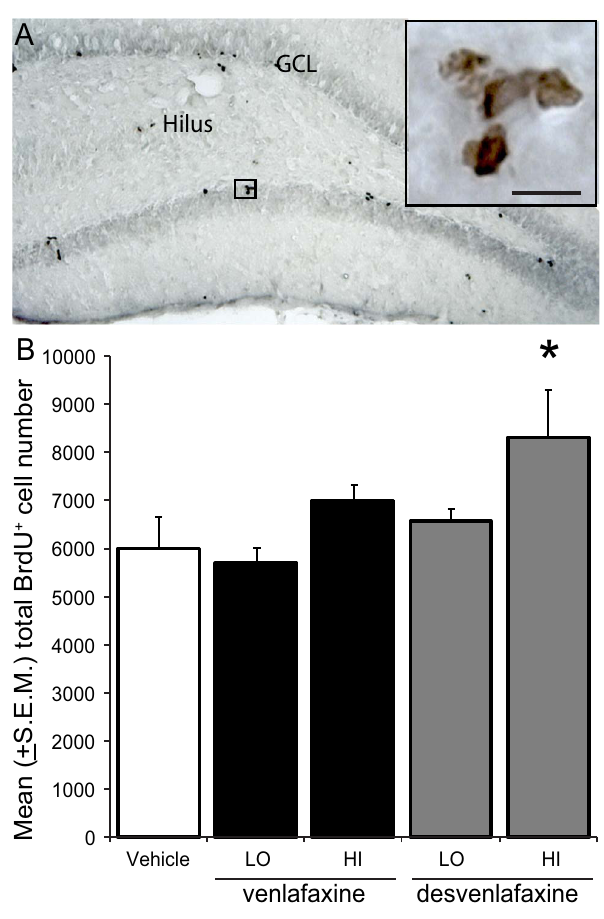
Figure 2. High dose desvenlafaxine increases NPCproliferation and survival in the DG of rats. A )Representative brightfield image of BrdU + cellsrevealed in the dentate gyrus of a vehicle-treated rat using DAB BrdU (inbrown). Scale bar =50 m m. B) Stereological estimates revealed more 10–14day-old BrdU + cells in the dentate gyriof DES-HI- versus vehicle-treated rats ( p =0.01*).